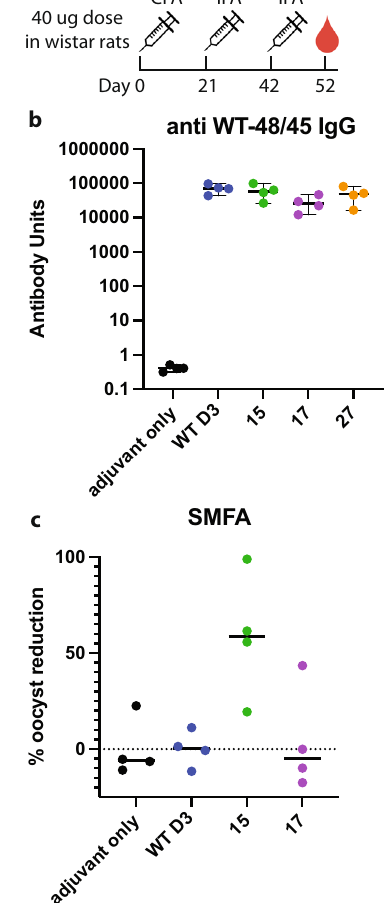
Fig. 2 Immunization of rats with Pfs48/45 immunogens elicits TRA. a Immunization and blood draw regimen. b IgG antibody titers to WT Pfs48/45 D3. Median values and 95% con fi dence intervals are displayed. c TRA of serum from immunized rats with median values displayed. Dashed line indicates 0% TRA relative to adjuvant only